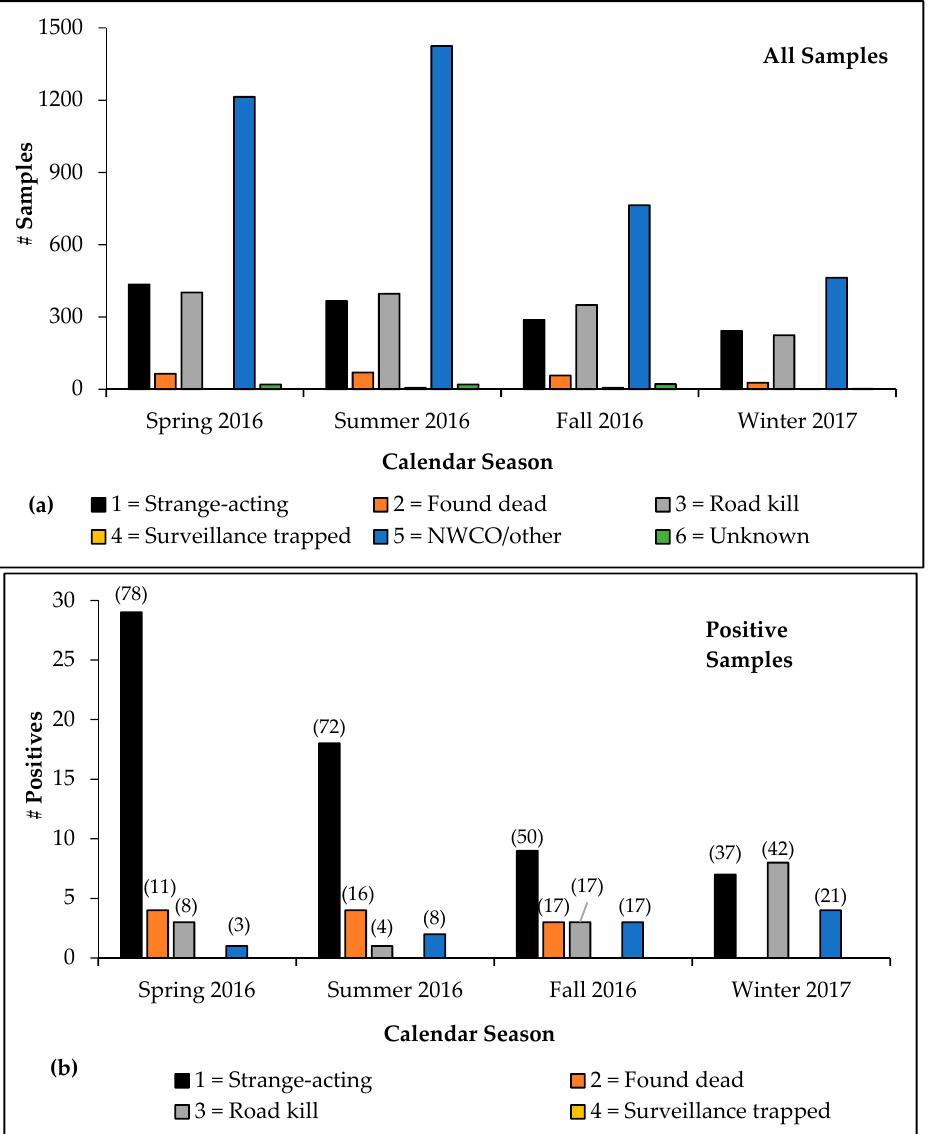
Figure 3. Comparison of enhanced rabies surveillance samples collected by season and sample category by Wildlife Services, spring 2016–winter 2017: ( a ) All samples and ( b ) Rabies-positive samples (value represents percent of all rabid animal samples detected according to sample category each season).